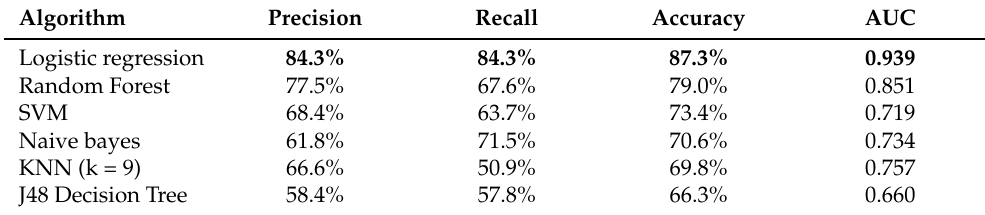
Table 5. Performance comparisons of different classification algorithms (10-fold cross